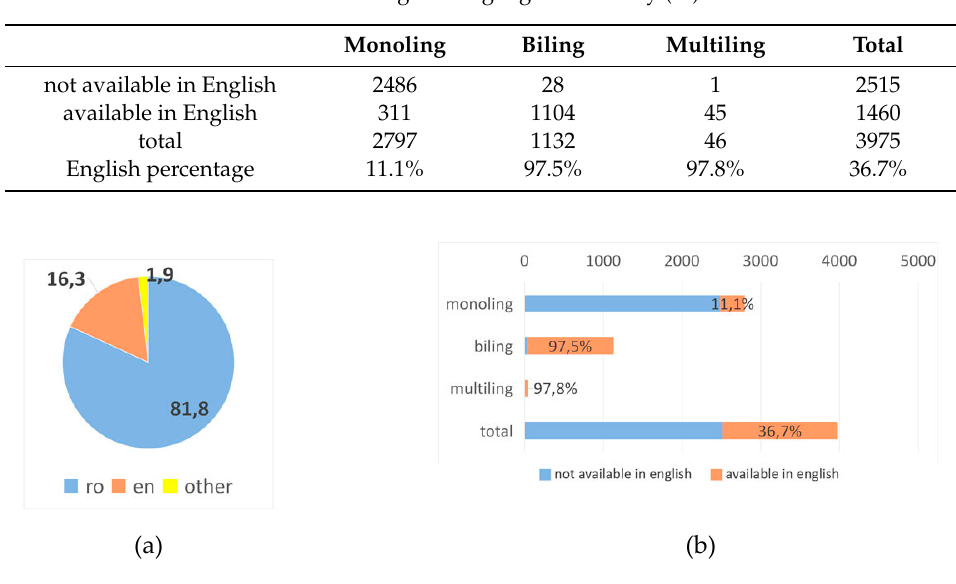
Table A47. Primary languages (sk).